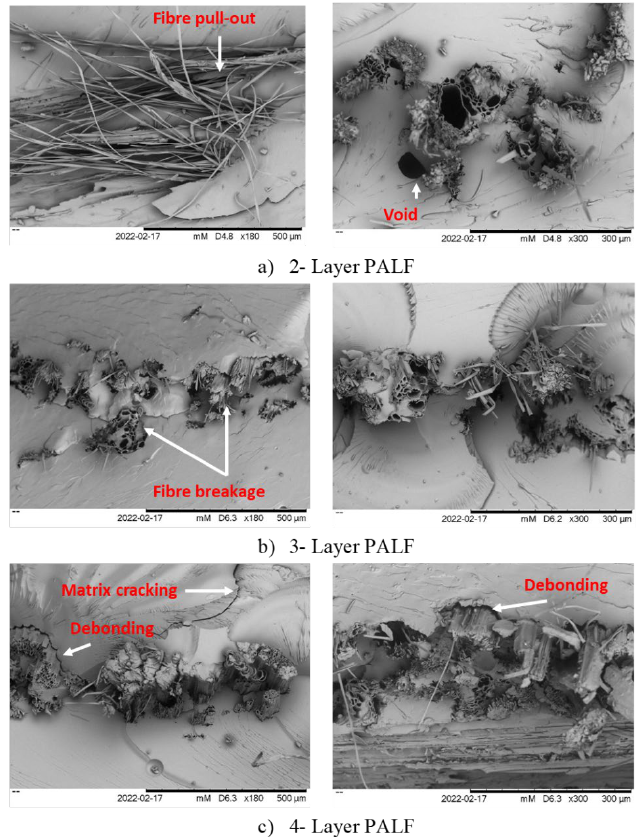
Figure 5. Tensile fracture of woven PALF/epoxy composites; ( a ) 2-layer, ( b ) 3-layer, ( c ) 4-layer.